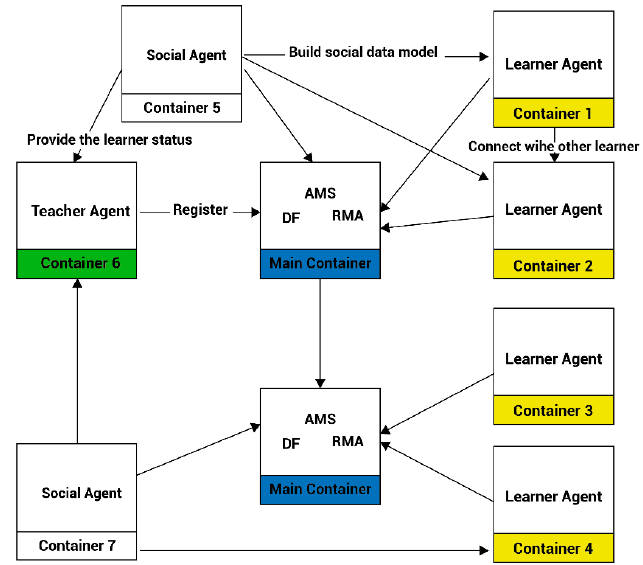
Figure 11. Proposed architectural design for collaborative mobile learning multi-platform using JADE-LEAP.